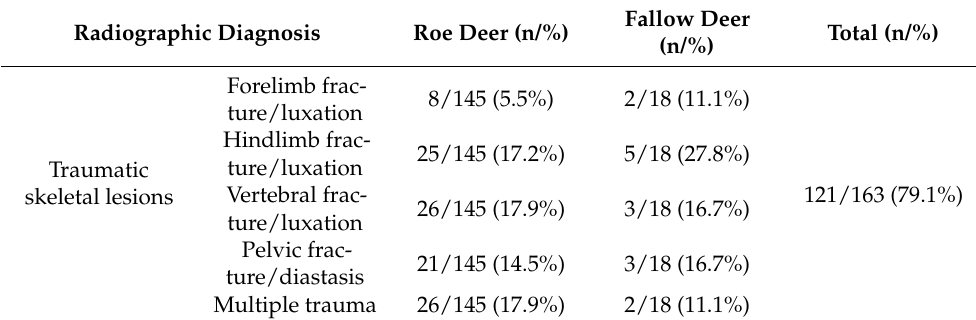
Table 6. Radiographic diagnosis expressed as the number and proportions (n/%) of roe deer, fallow deer, and total population.